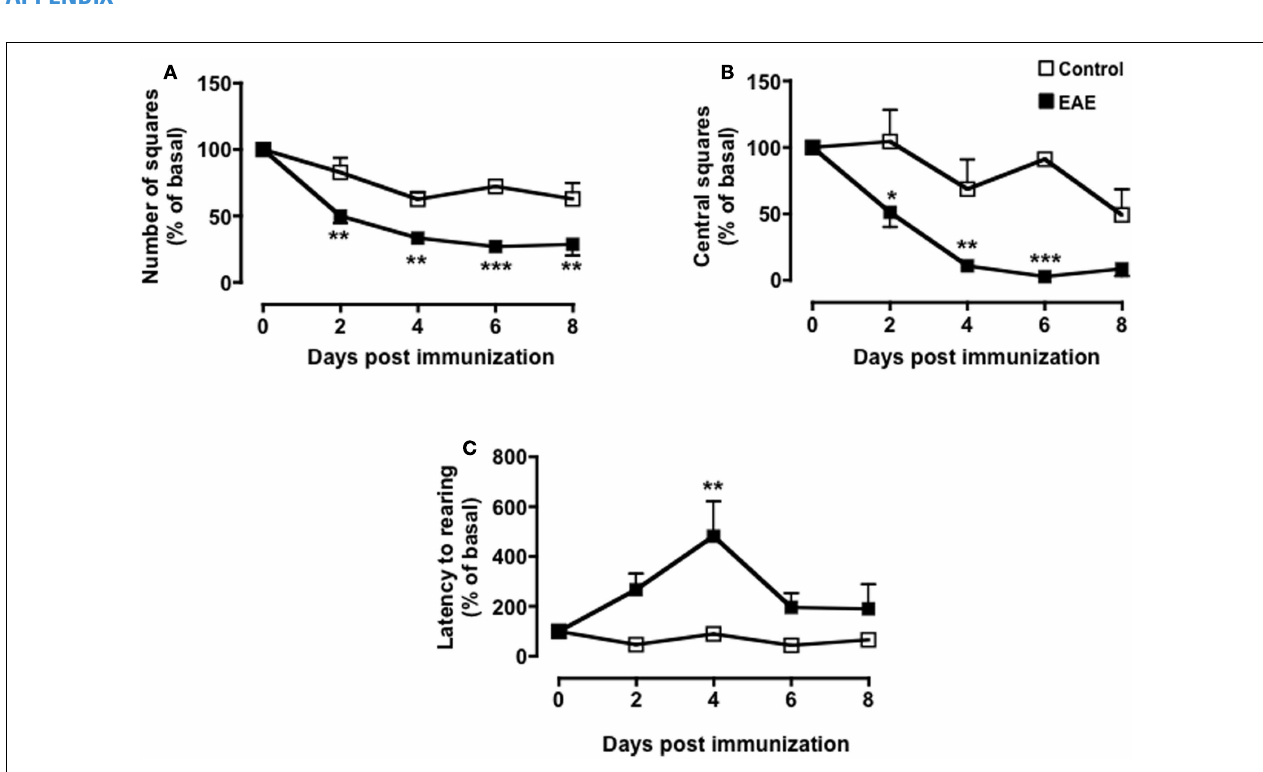
assessed during a 5-min test.Values are expressed as mean percentage ± SEM for six to eight mice and are representative of N = 5–6